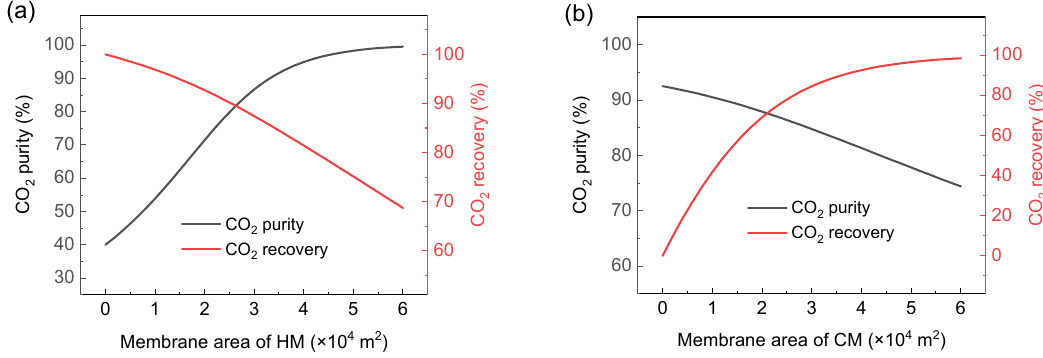
Figure 5. The relationship between the purity and recovery of CO 2 under the condition of pressure ratio of 30 and selectivity of 20 when membrane area changes ( a ) the change of the membrane area of HM ( b ) the change of the membrane area of CM.